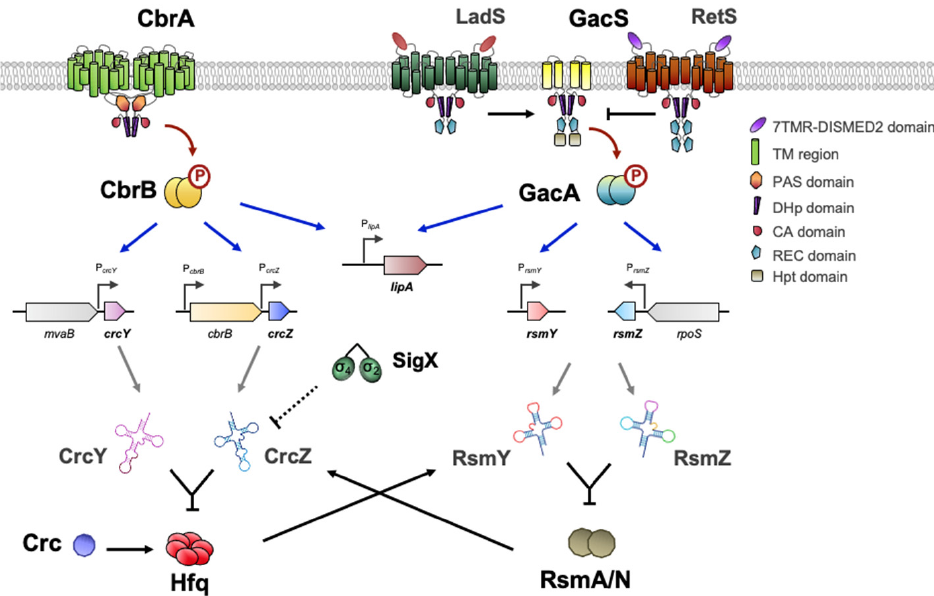
Figure 5. Representation of the parallelism and cross-talk of the CbrAB and GacSA regulatory systems in Pseudomonas . Under induction conditions, the sensor kinases CbrA and GacS are activated by autophosphorylation in an ATP-dependent reaction, and subsequently transfer the phosphoryl group to their response regulators, CbrB and GacA, respectively. Phosphorylation of CbrB and GacA leads to their oligomerization and binding to promoter regions of sRNAs genes ( crcZ and crcY for CbrB; rsmZ and rsmY for GacA) and other target genes such as lipA . Sufficient amounts of the sRNAs promote sequestration of Hfq and RsmA or RsmN, by direct binding to specific domains of the proteins. Each of these regulatory pathways also converge in the protein–protein interaction between Hfq and RsmY, and RsmN and RsmA with CrcZ. On the other hand, the sigma factor SigX has a negative effect on the CrcZ levels. Blue and black arrows represent transcriptional and post-translational regulation, respectively. Dotted lines indicate an indirect regulation. The domains that make up the architecture of the sensor kinases are shown in the legend.